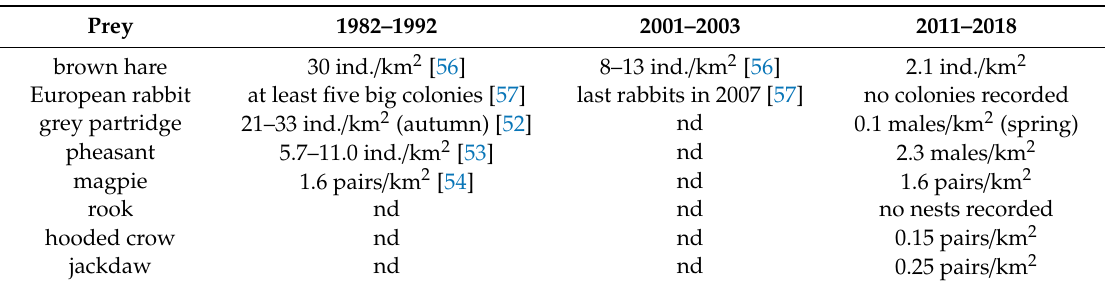
Table 6. The changes in prey available to goshawks in the area of study (central Poland, vicinity of Rog ó w village, Experimental Forest Station of Warsaw University of Life Sciences) in the three compared study periods: The sources of data are from 1982–1992, 2001–2003, published data (references in square brackets), and 2011–2018, the current data. nd: no data